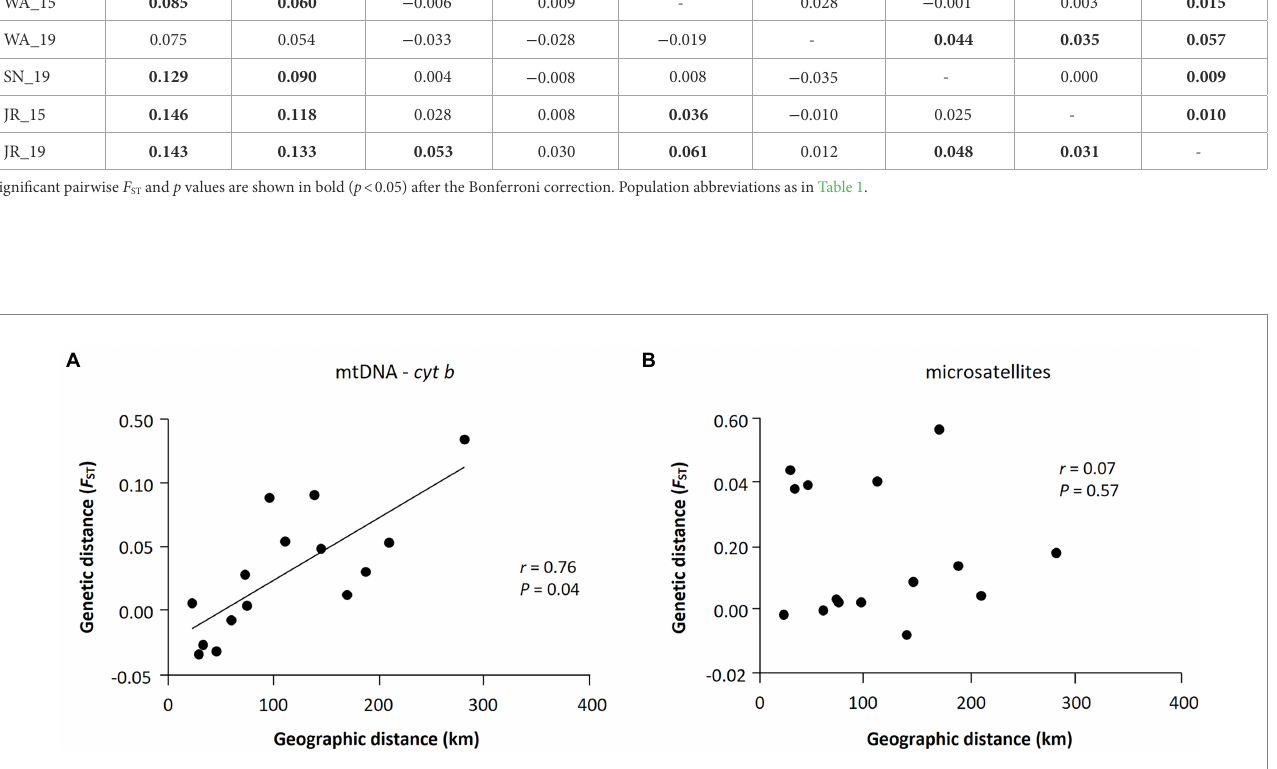
FIGURE 4 Results of isolations-by-distance (IBD) analysis with the Mantel tests for Apodemus agrarius in national parks within the Baekdudaegan Mountain Range (BMR). (A) and (B) are the results of mtDNA and microsatellites, respectively. The relationship between genetic ( F ST ) and geographic distances was statistically significant only for the mtDNA data set ( r = 0.76, p =